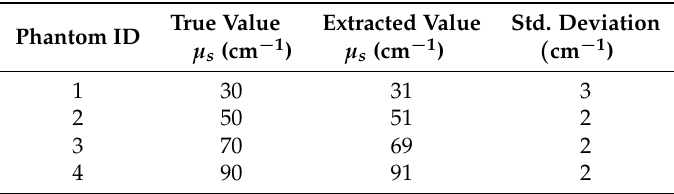
Table 2. Reconstruction of scattering coefficient of top layer from simulated data with prior knowledge of absorption coefficient of top layer and both optical properties of bottom layer (Problem-II).